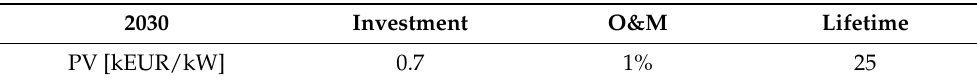
Table 2. Initial inputs for techno-economic analysis.